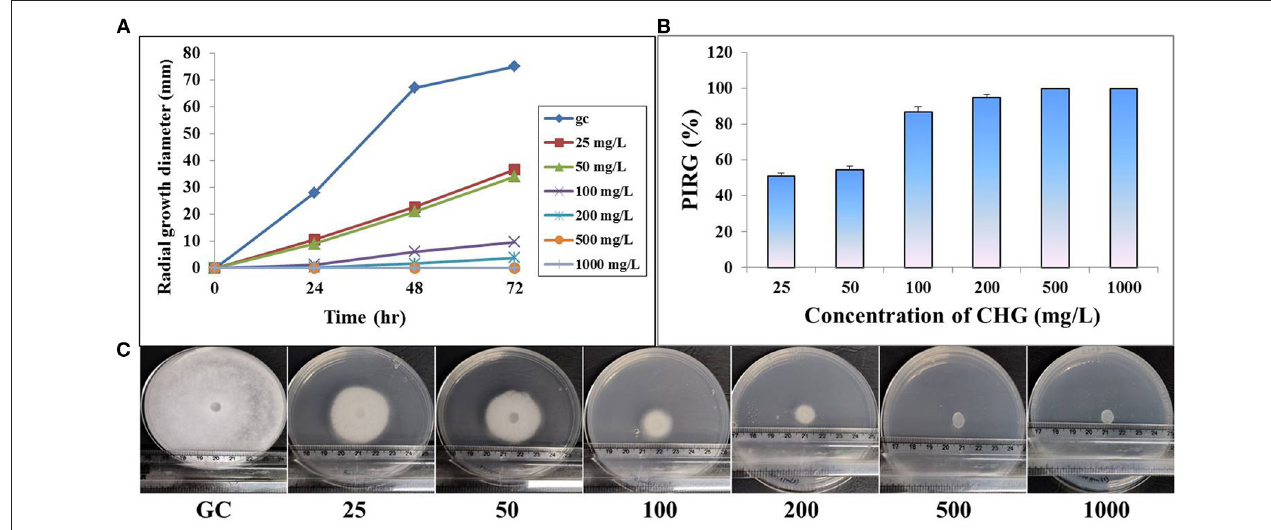
FIGURE 4 | Effect of CHG on radial growth of Saprolegnia australis. (A) Time dependent mycelial growth of S. australis on glucose yeast extract agar incorporated with different concentrations of chlorhexidine (0, 25, 50, 100, 200, 500, and 1,000 mg/L). (B) Estimation of percent inhibition on radial growth of S. australis on CHG